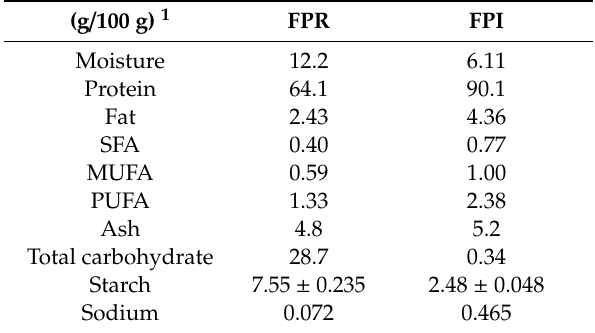
Table 1. Nutritional composition of faba bean protein-rich flour (FPR) and faba bean protein isolate (FPI). (g / 100 g) 1 FPR FPI